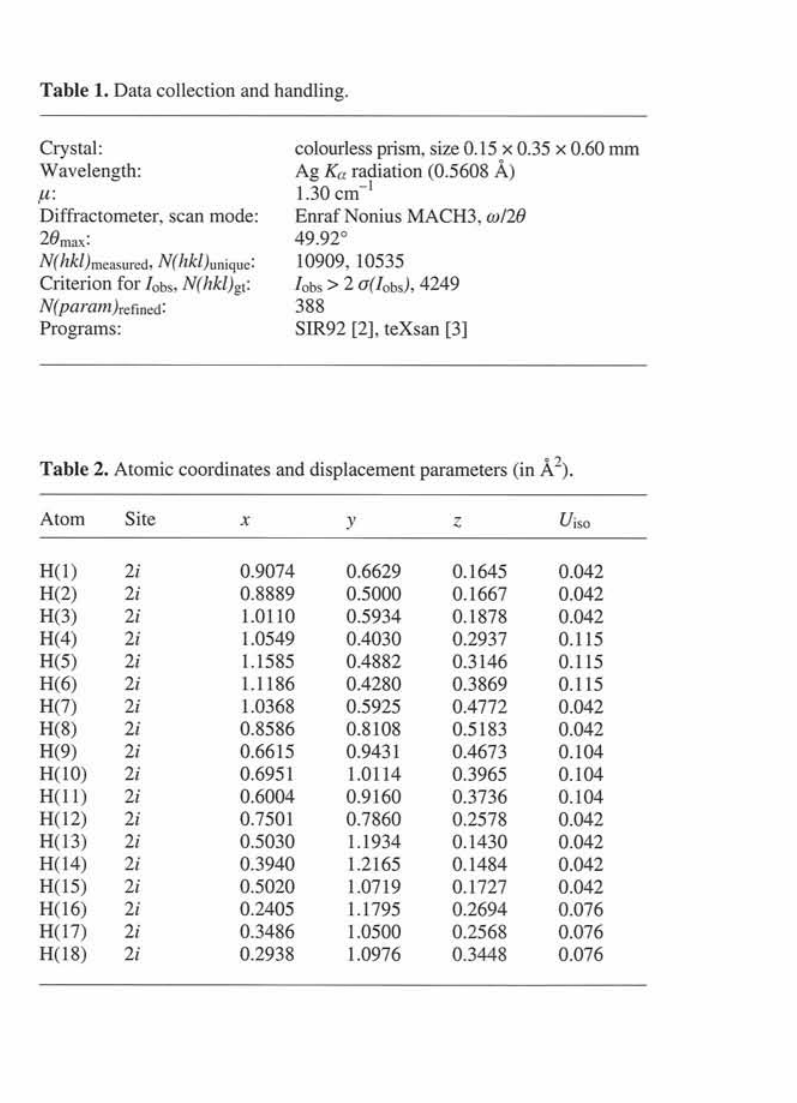
Table 1. Data collection and handling.